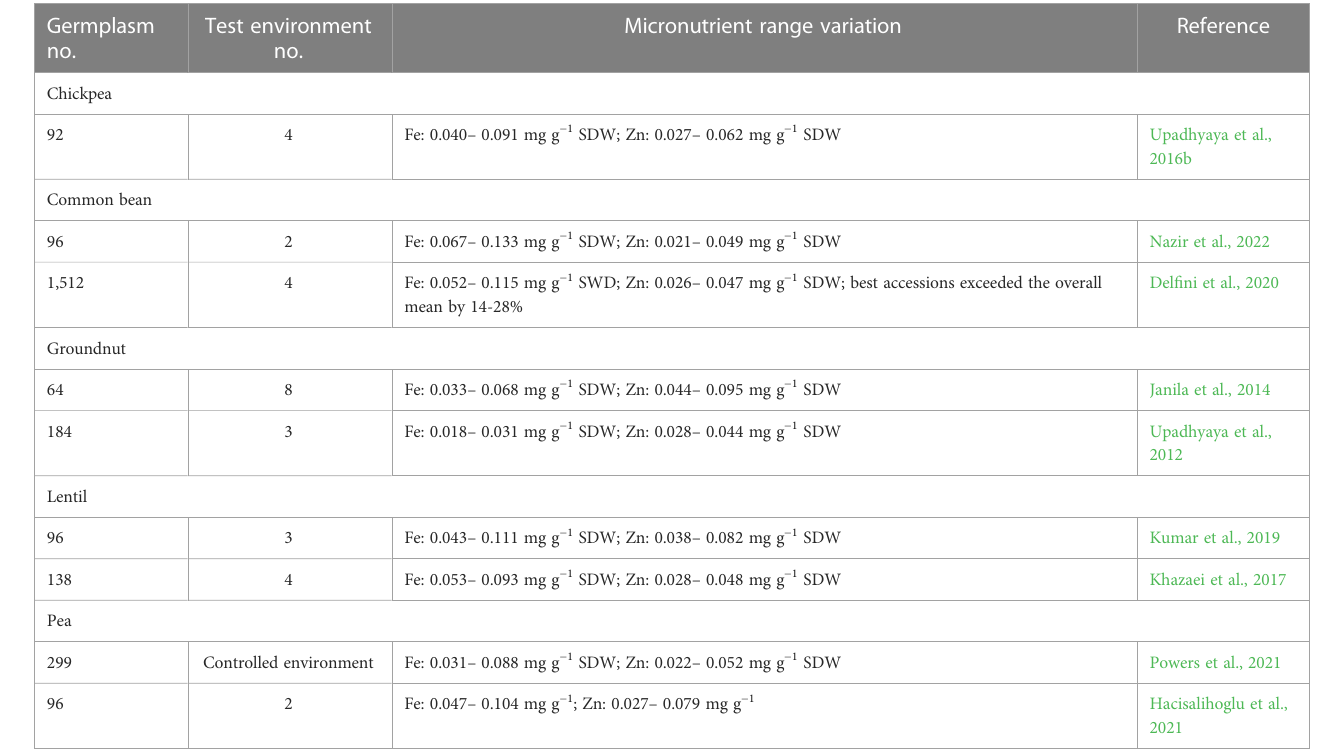
TABLE 2 Genetic variation for seed iron (Fe) and zinc (Zn) contents among food legume crop germplasm. Germplasm